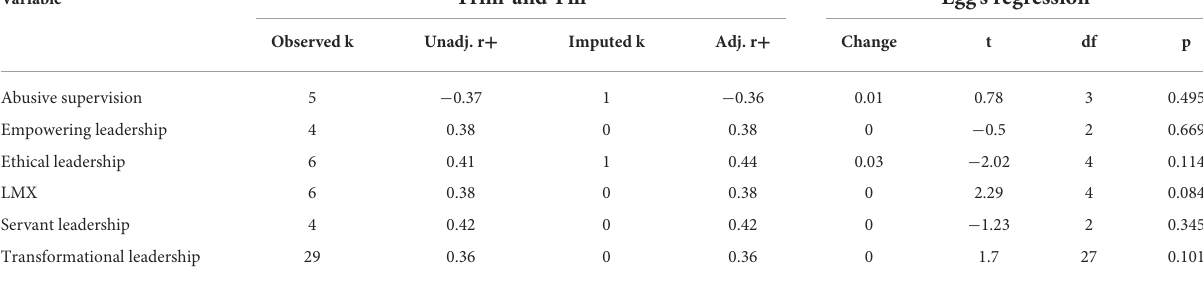
TABLE 7 Publication bias